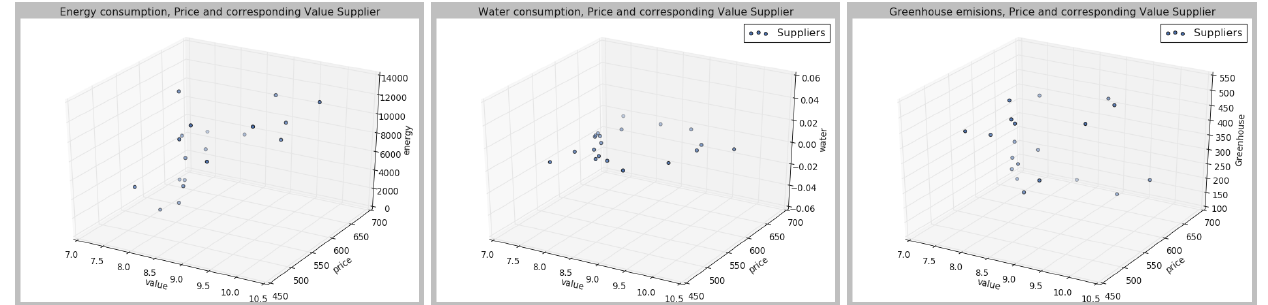
Figure 4. Case 2, according to the preferences described in Table 3.